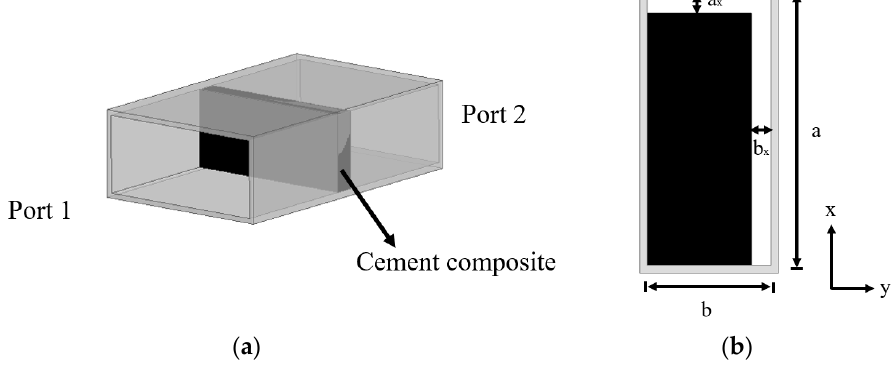
Figure 3. Geometrical configuration of the waveguide : ( a ) geometry of the simulated waveguide with composite. ( b ) Cross-section of the waveguide for the dimensional analysis.